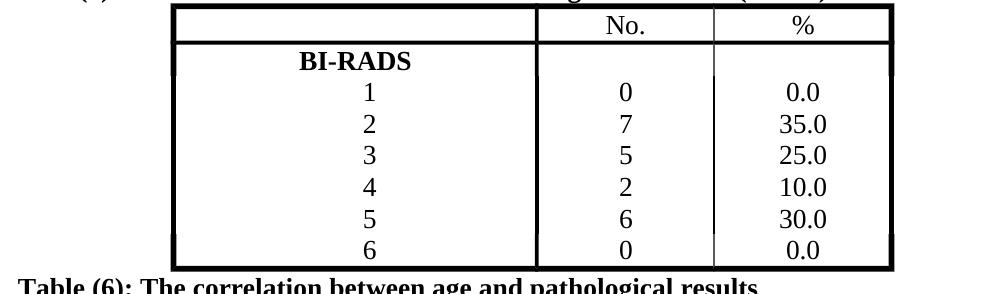
Table (6): The correlation between age and pathological